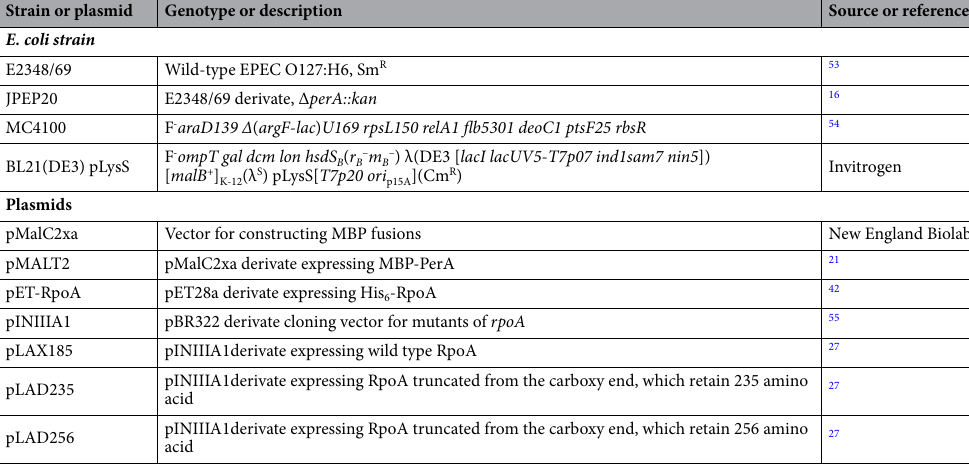
Table 1. Strains and plasmids used in this